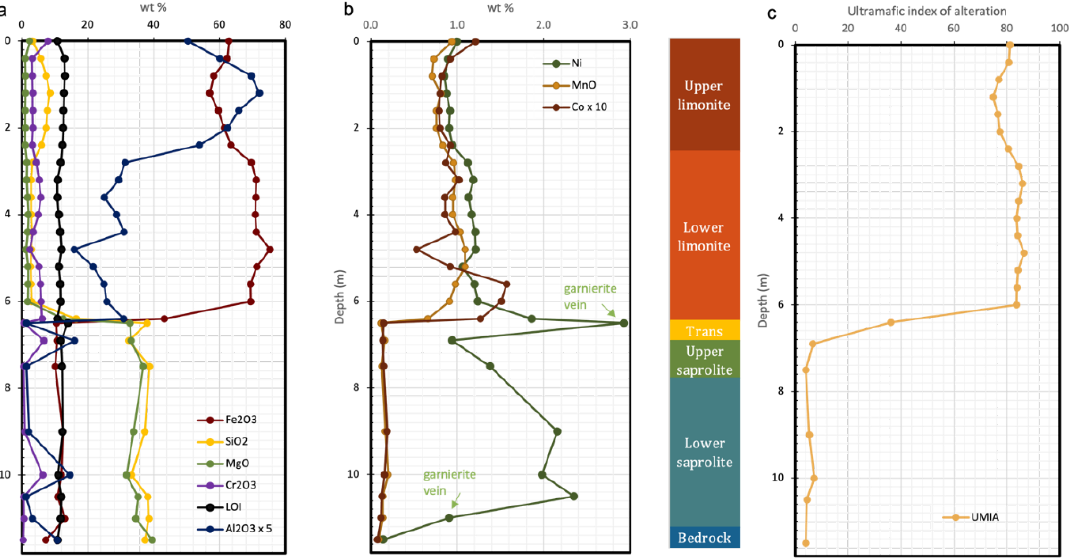
Figure 8. ( a ) Major and ( b ) minor element geochemistry of the studied profile and the corresponding laterite horizons. ( c ) Calculated ultramafic index of alteration (UMIA) [41]. Note the relatively high Ni contents of the upper garnierite vein.